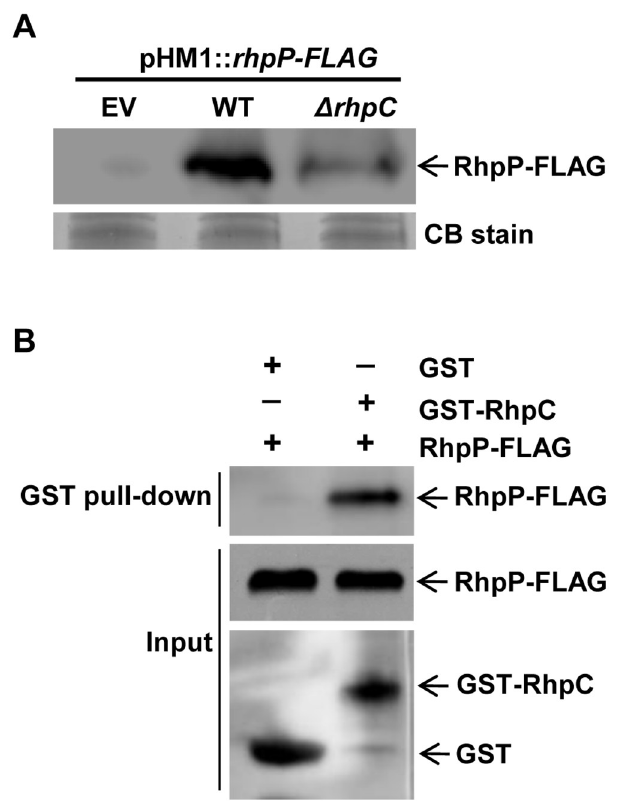
Fig 5. RhpC interacted with and stabilized RhpP protein. (A) Wild type Psph and Δ rhpC mutant constitutively expressing RhpP-FLAG were cultured in KB. The total protein in bacterial cells was examined using Western blot with anti-FLAG antibody. Psph strain carrying the empty pHM1 vector (EV) was used as control. (B) Purified GST or GST-RhpC coupled with the Glutathione Sepharose beads was incubated with the purified RhpP-FLAG protein and then precipitated by centrifugation. Protein pulled down by the beads was assayed using Western blot with anti-FLAG antibody. CB stain, Coomassie Blue stain.